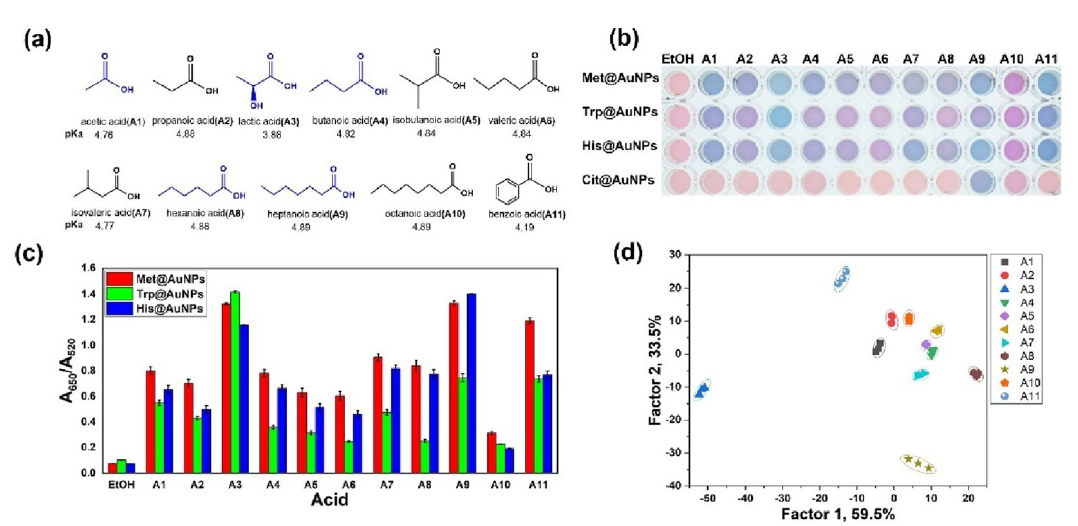
Figure 4. ( a ) Molecular structures of main organic acids in SAB, ( b ) color change patterns, ( c ) response (A650/ A520) patterns, and ( d ) two-dimensional canonical score plots for the first two factors of the 11 organic acids (0.5 g/L) obtained using the sensor array based on